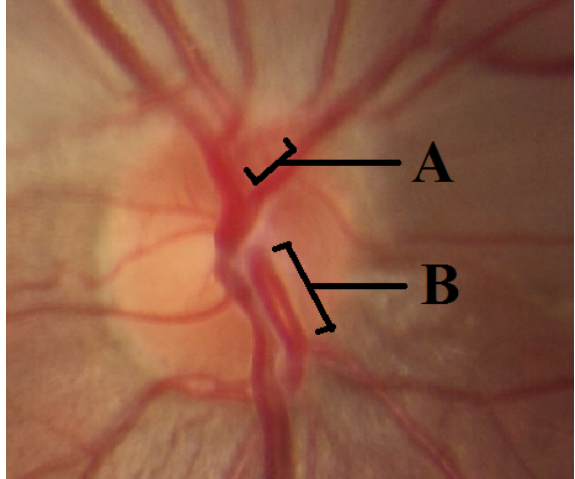
Figure 2: Fundus photography of the right optic nerve head showing separated emergence of the superior and inferior hemi-trunks of the central retinal artery. A: superior hemi-trunk of the central retinal artery. B: inferior hemi-trunk of the central retinal